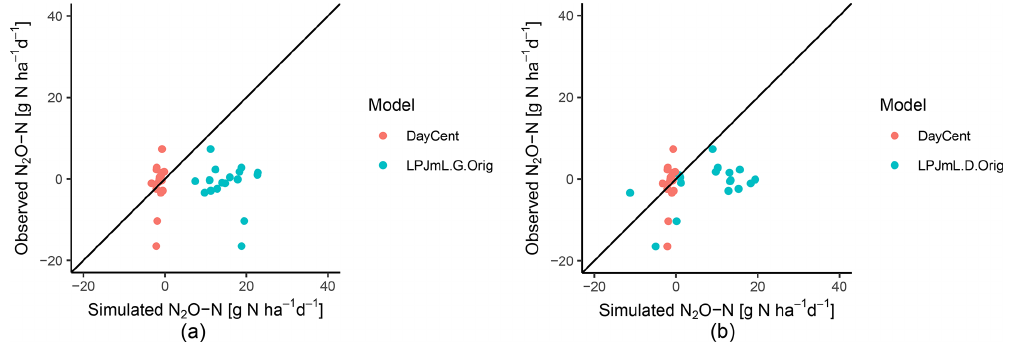
Figure 2. Comparison of observed and simulated effects after converting to no-tillage (i.e., the difference between no-tillage and tillage). The data refer to yearly averages of N 2 O emissions and models LPJmL.G.Orig (a) , LPJmL.D.Orig (b) and DayCent of all four sites and years of the experiments.